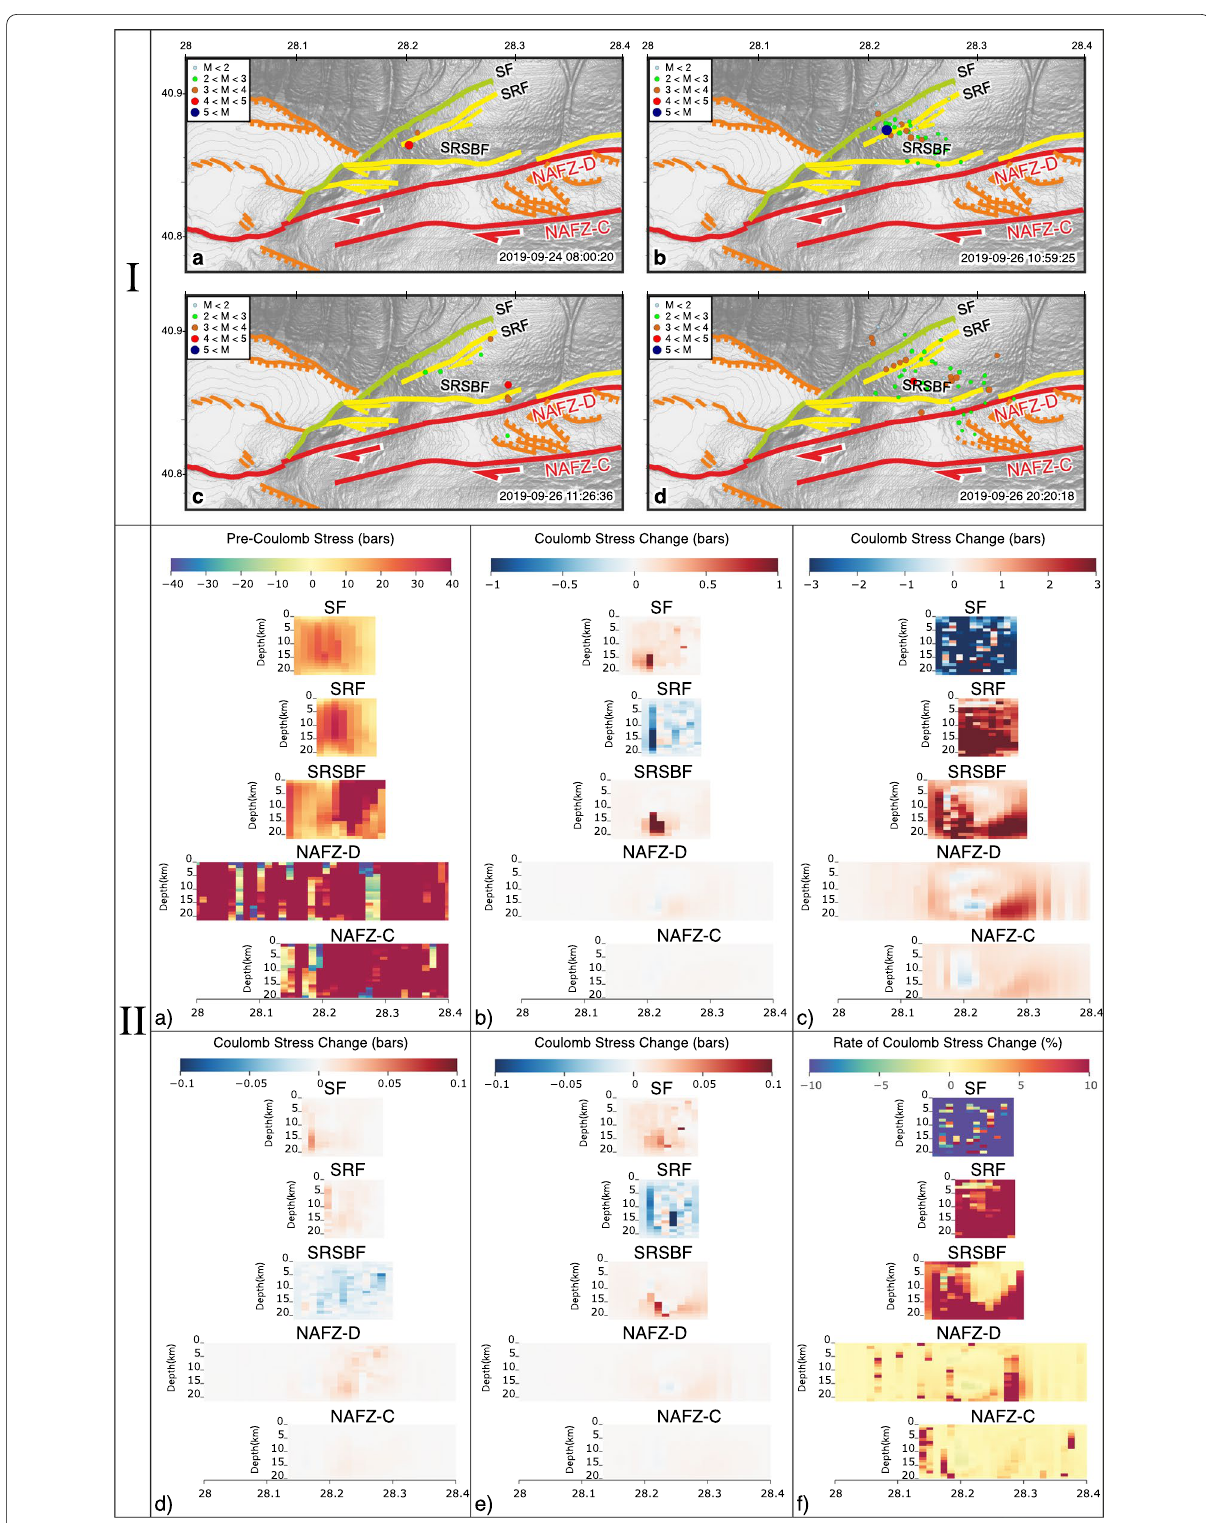
Fig. 6 (See legend on previous